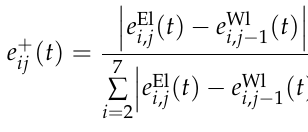
( t ) , e + ( t ) , and e + ( t ) : ( a ) Point P2, ( b ) Point P6, ( c ) Point 2 j 6 j 7 j